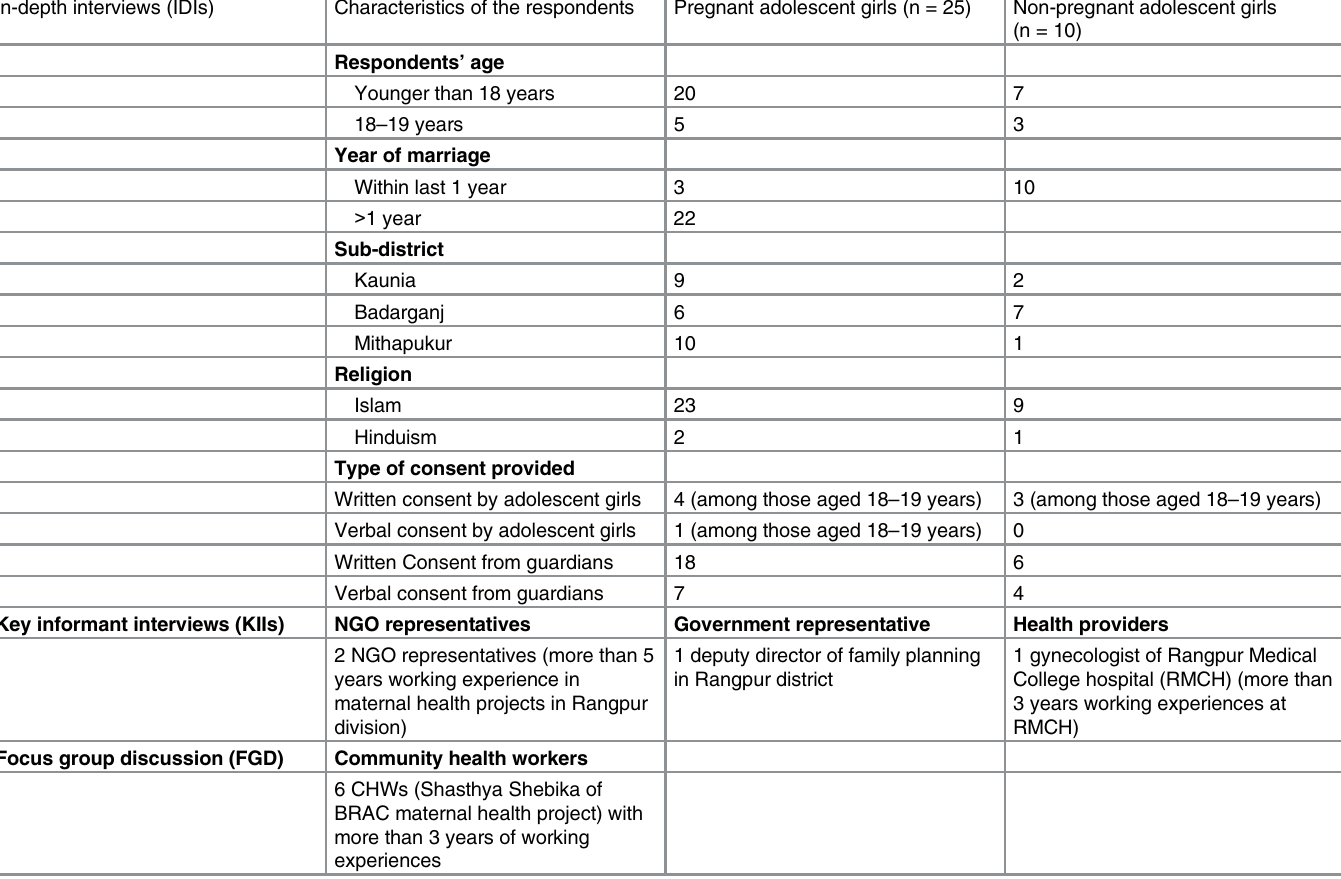
Table 1. Data collection methods and